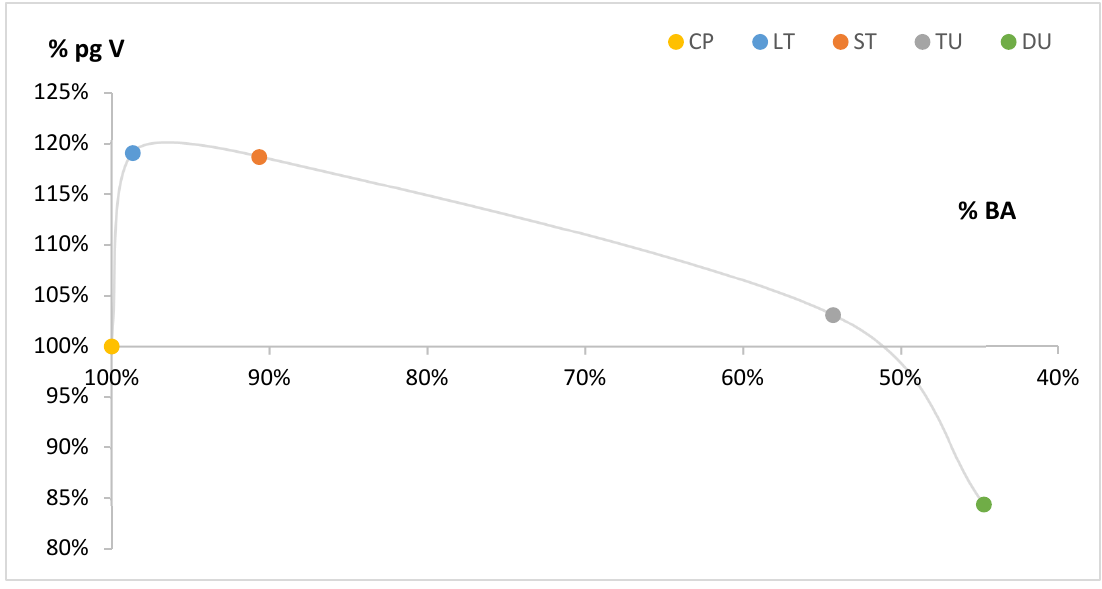
Figure 3. Variation in the current volume increment (pg V) expressed as a percentage of that of the Control Plots (100%) with respect to BA expressed as a percentage of the CP BA (100%).